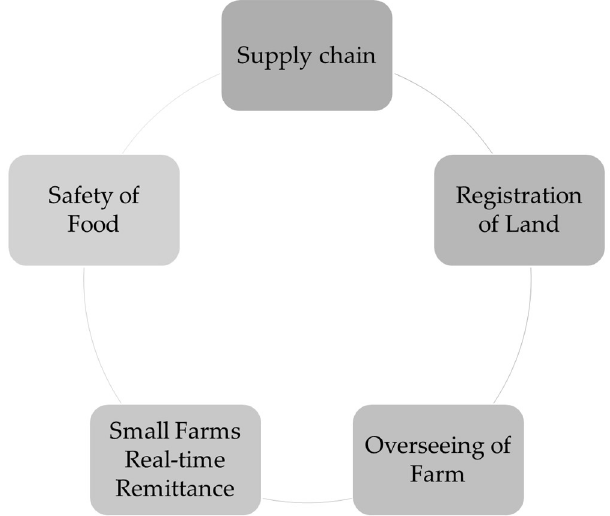
Figure 8. Blockchain applications in smart agriculture.